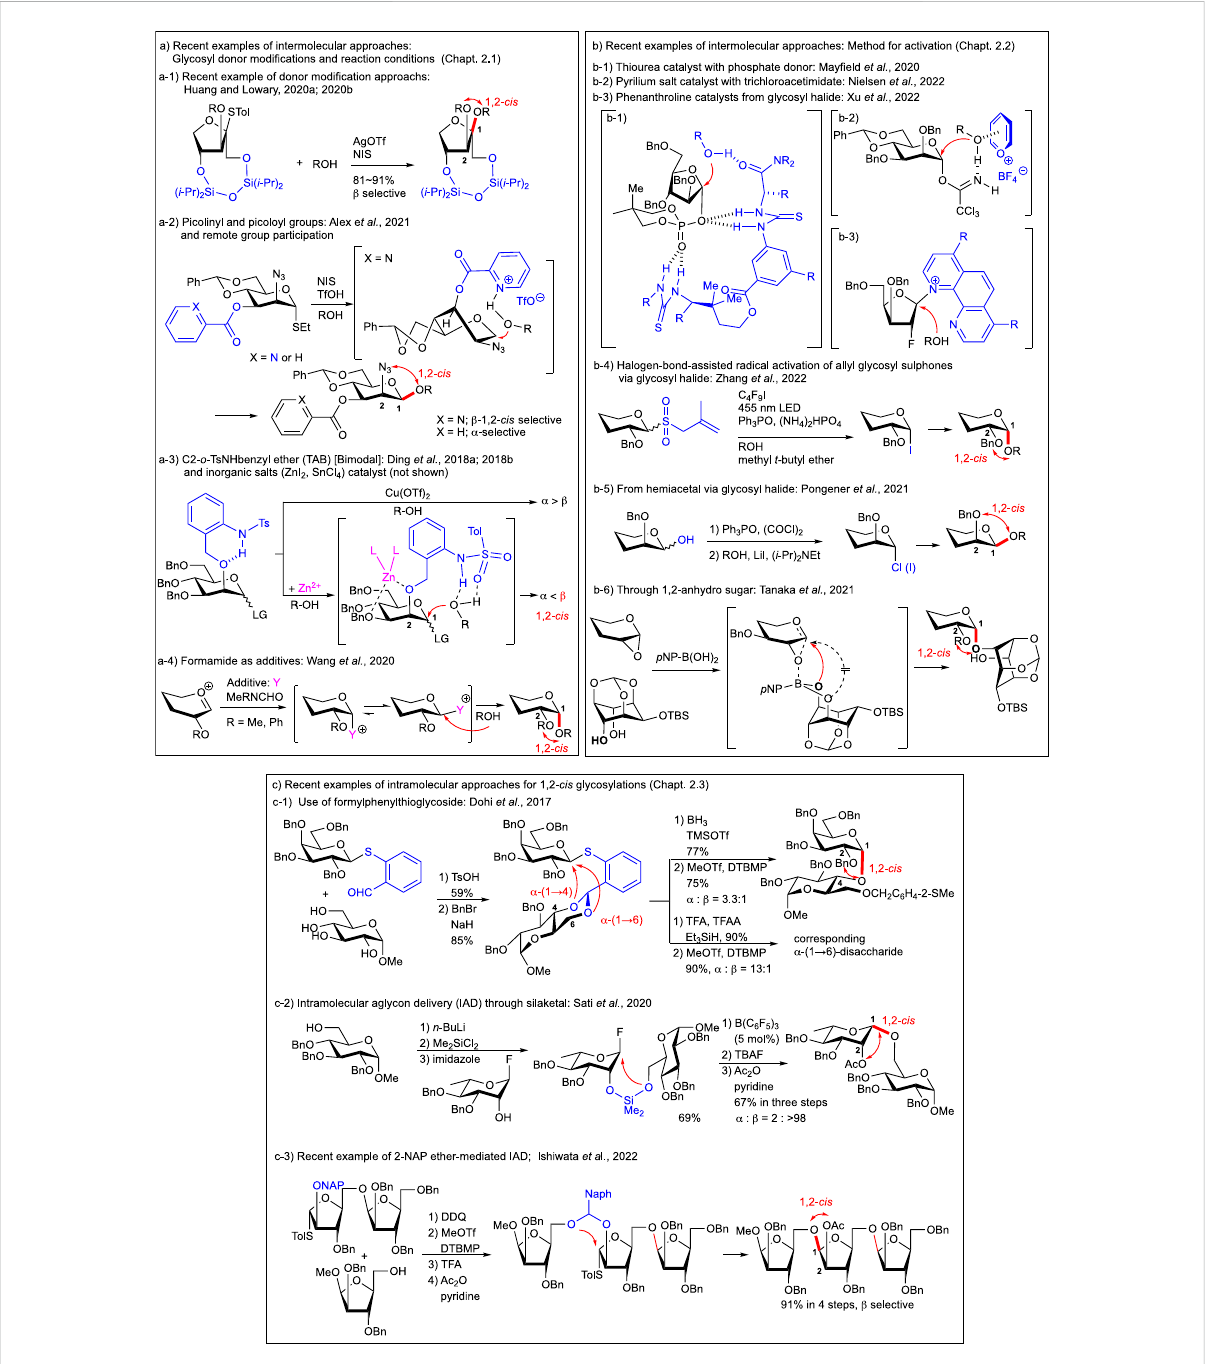
FIGURE 2 Recent advances in 1,2-cis glycosylations: some examples. (A) Recent examples of intermolecular approaches: Glycosyl donor modi fi cations and reaction conditions. a-1) Recent example of donor modi fi cation approachs; a-2) Picolinyl and picoloyl groups and remote group participation; a-3)C2-o-TsNHbenzylether(TAB)[Bimodal]andinorganicsalts(ZnI 2 ,SnCl 4 )catalyst(notshown);a-4)Formamideasadditives. (B) Recentexamples of intermolecular approaches: Method for activation. b-1) Thiourea catalyst with phosphate donor; b-2) Pyrilium salt catalyst with trichloroacetimidate;b-3)Phenanthrolinecatalystsfromglycosylhalide;b-4)halogen-bond-assistedradicalactivationofallylglycosylsulphonesvia glycosyl halide: b-5) From hemiacetal via glycosyl halide; b-6) Through 1,2-anhydro sugar. (C) Recent examples of intramolecular approaches for 1,2-cisglycosylations.c-1)Useofformylphenylthioglycoside;c-2)Intramolecularaglycondelivery(IAD)throughsilaketal;c-3)Recentexampleof2- NAP ether-mediated